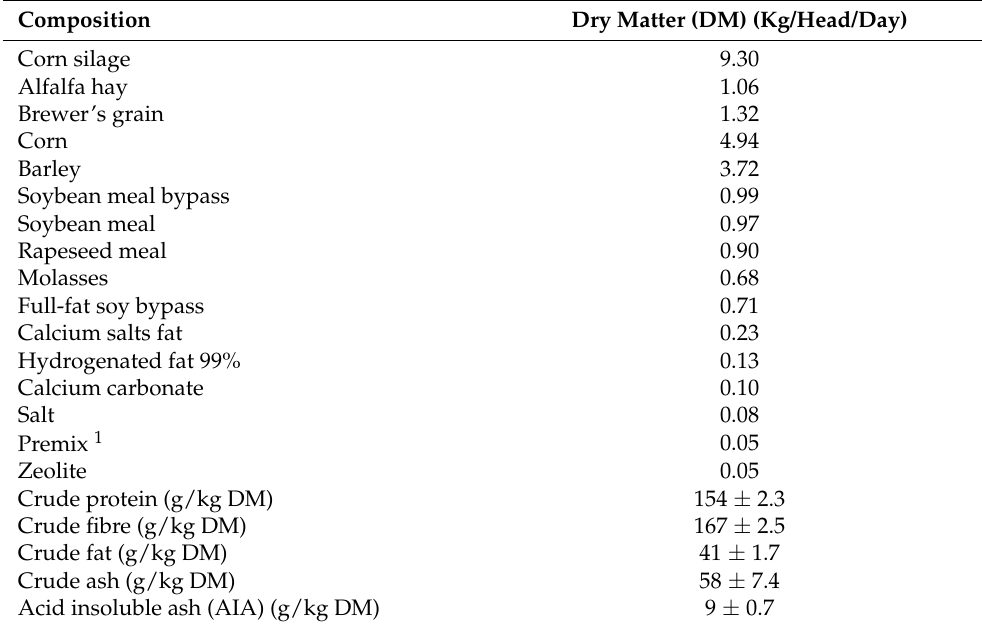
Table 1. Composition and chemical analysis of